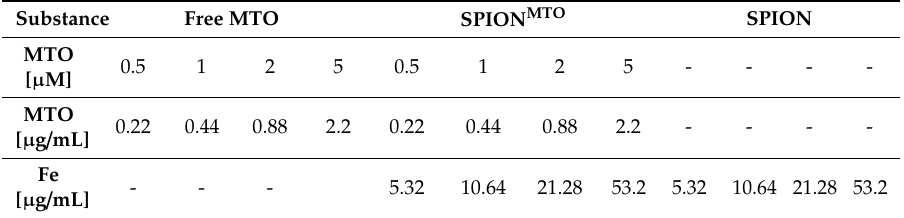
Table 2. Amount of mitoxantrone (MTO) and iron in MTO, SPION MTO and non-loaded